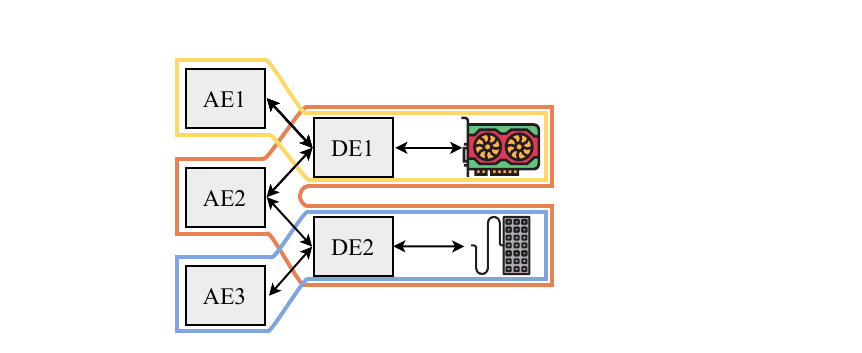
Figure 4: Three example composite enclaves in our software design with application enclaves (AE), driver enclaves (DE), a GPU, and a keyboard. Note that the red composite enclave is spanning over two external devices and driver enclaves isolate the data from the different application